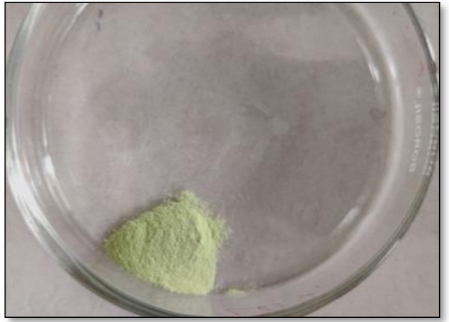
Figure 17. Final powder form of synthesized tungsten oxide.